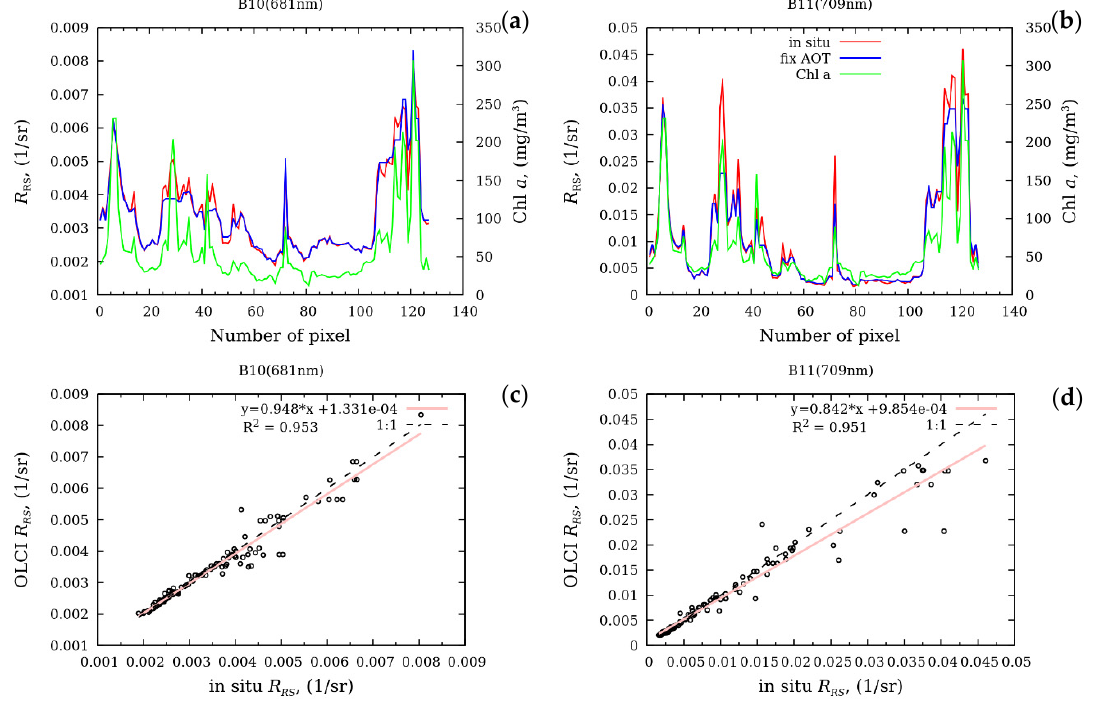
Figure 13. Validation results of R rs retrieved using fixed AOD algorithm (blue line): in B10(681) band ( a ); in B11(709) band ( b ), the red line is measured R rs , the green line is the concentration of Chl a measured along the motorboat roue; the scattering diagrams of the retrieved OLCI R rs and measured one in B10(681) band ( c ), and B11(709) band ( d ). Line 1:1 (dotted line), linear regression (pink line). The number of match-ups is 127.